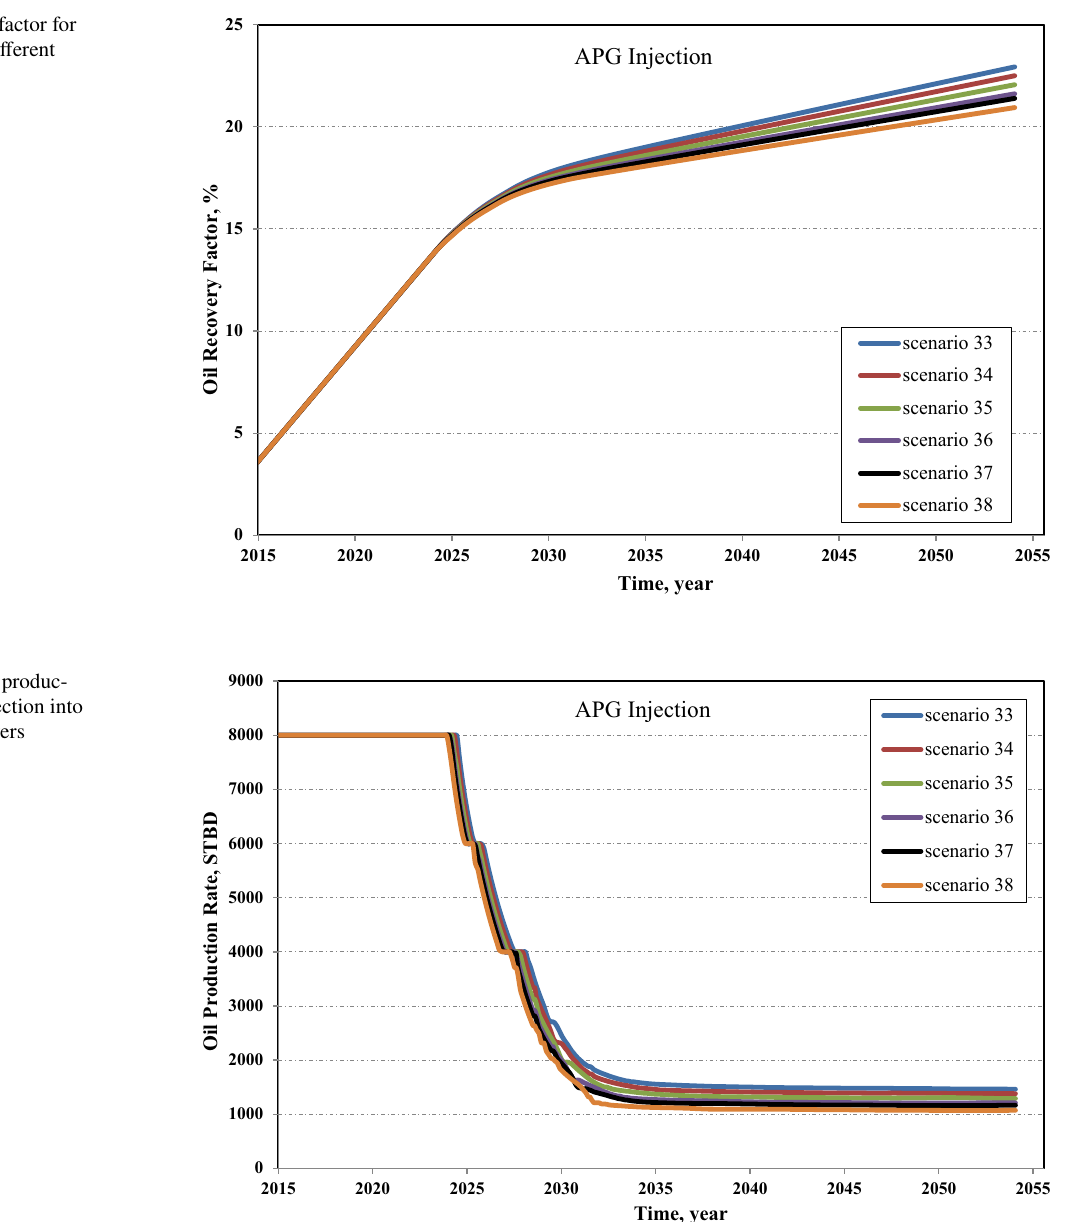
Fig. 14 Reservoir oil produc- tion rate for APG injection into different reservoir